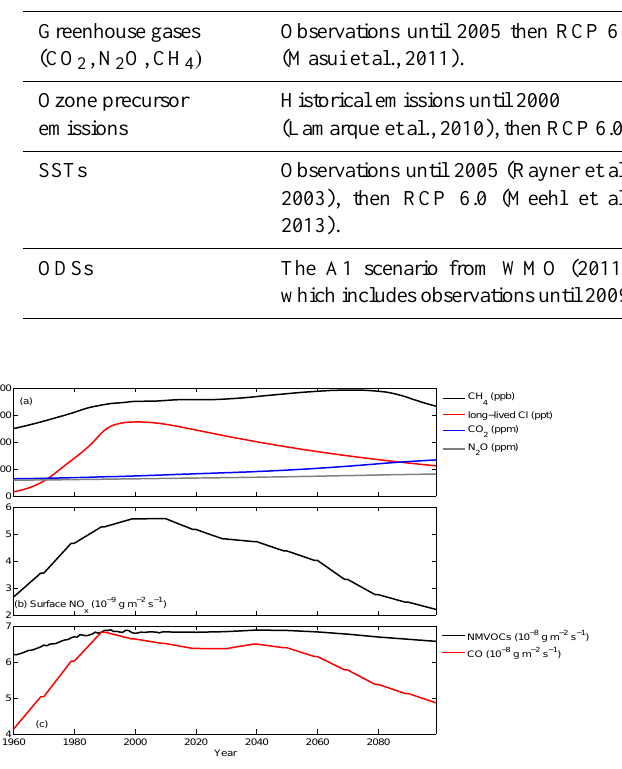
Figure 1. Boundary conditions used in the REF-C2 simulation (global-mean concentrations/emission fluxes). (a) CO 2 , CH 4 , N 2 O mixing ratios following RCP 6.0, and long-lived chlorine mixing ratios following the WMO A1 scenario for ODSs. (b) Surface NO x emission fluxes, following RCP 6.0. (c) Surface CO and NMVOC emission fluxes, following RCP